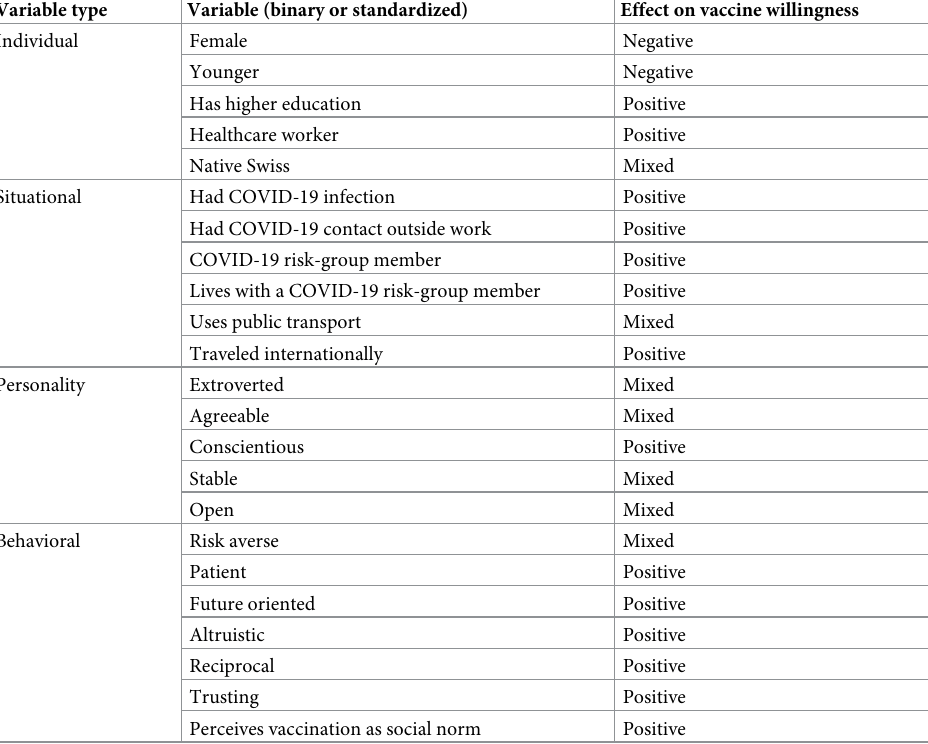
Table 1. Summary of